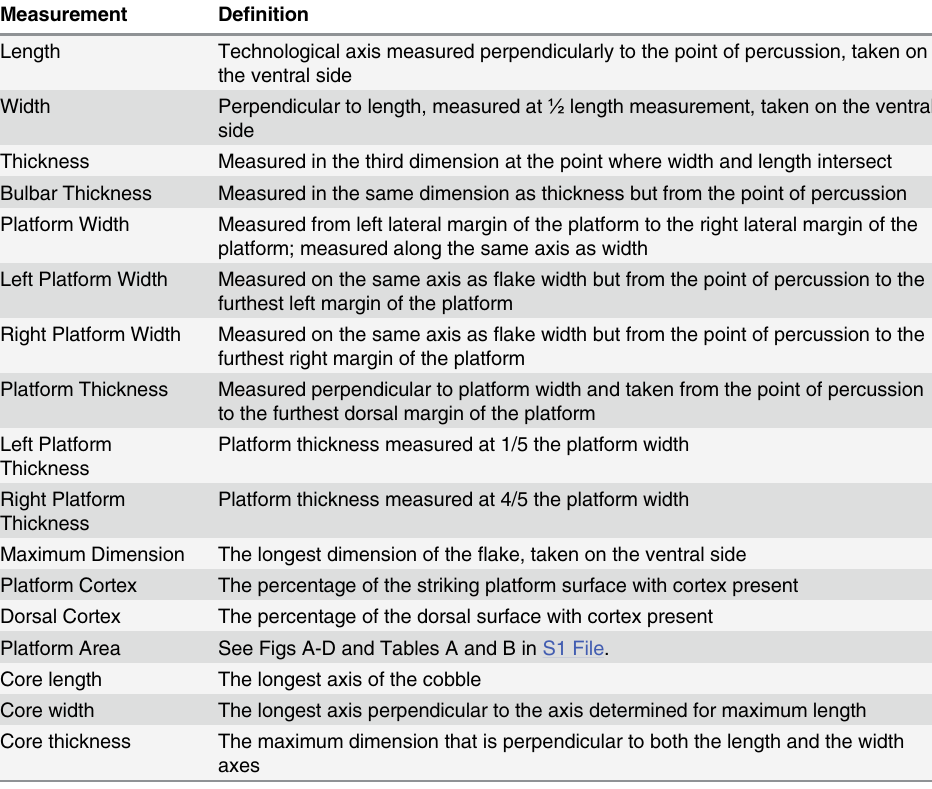
Table 1. Measurements taken on whole flakes and corresponding